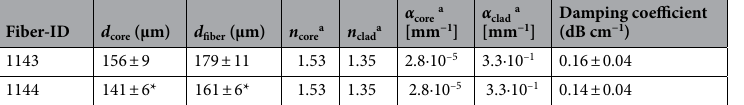
Table 1. Material parameters of the two POFs used in this work. Taken from 4 , except if stated otherwise. Experimental data displayed as mean ± standard deviation ( n = 10). *Value significantly different than that for fibre 1143 ( p < 0.01) 4 . a Data were taken resp. calculated from the datasheets of the polymers 25,26